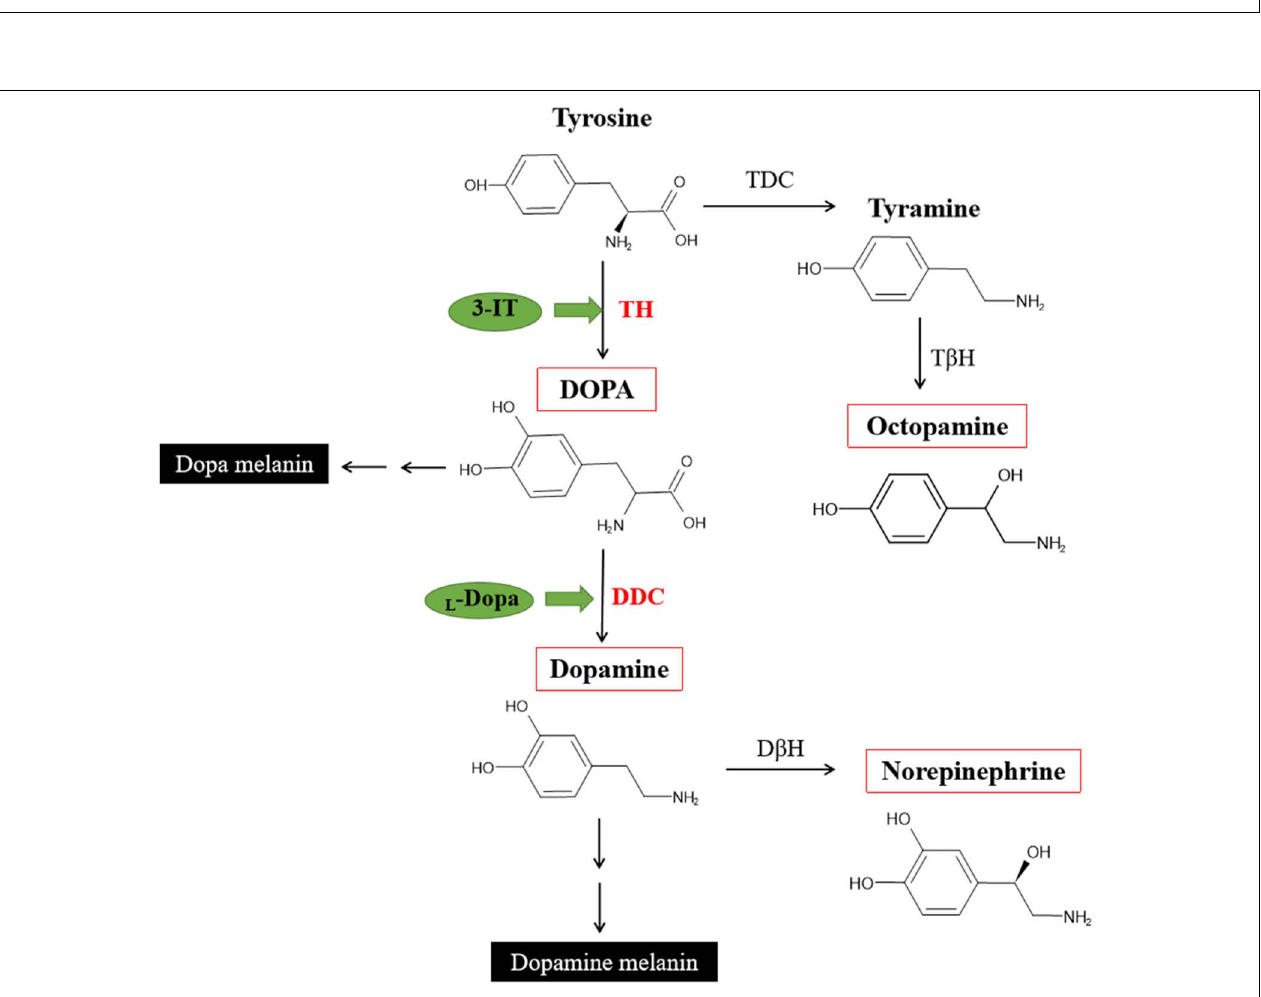
FIGURE 9 | Partial pathways for cuticular melanization in insects and DOPA, Dopamine, Norepinephrine, Octopamine synthesis [modified from Wittkopp et al. (2003), Roeder (2005), and Lange (2009)].